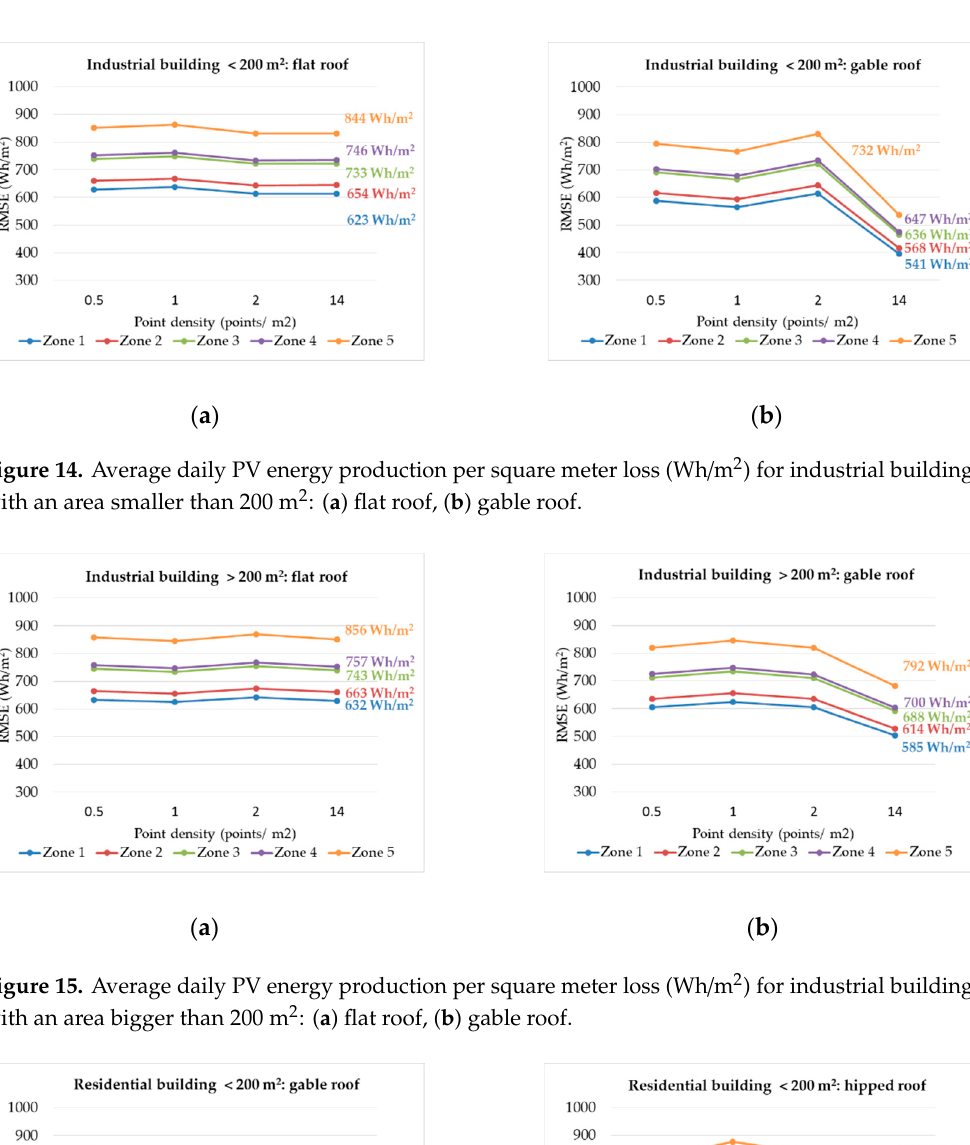
Figure 15. Average daily PV energy production per square meter loss (Wh / m 2 ) for industrial buildings with an area bigger than 200 m 2 : ( a ) flat roof, ( b ) gable roof.